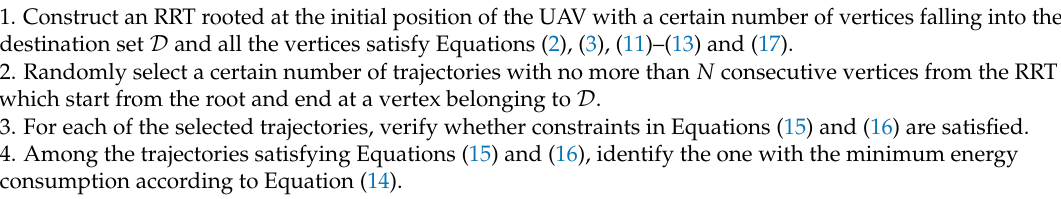
Table 1. UAV 3D Trajectory Planning